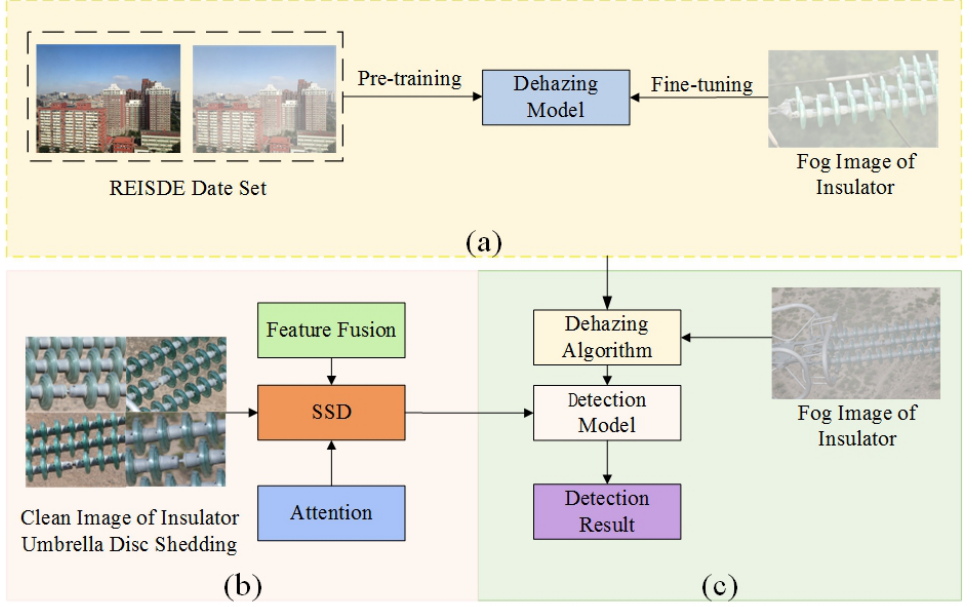
Figure 3. The overall process of umbrella disc shedding detection. ( a ) Dehaze model. ( b ) Training phase. ( c ) Testing